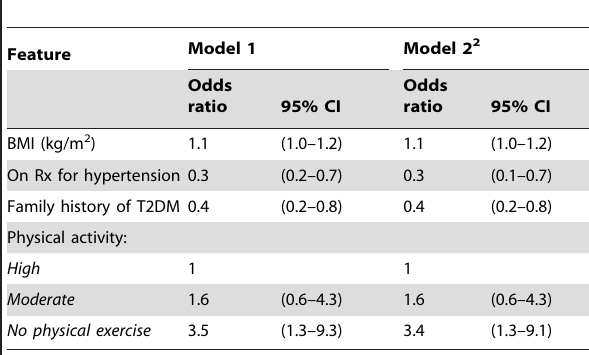
Table 4. Odds ratios (95% CI) of having undiagnosed compared to diagnosed type 2 diabetes – multivariate logistic regression adjusted for all significant covariates.